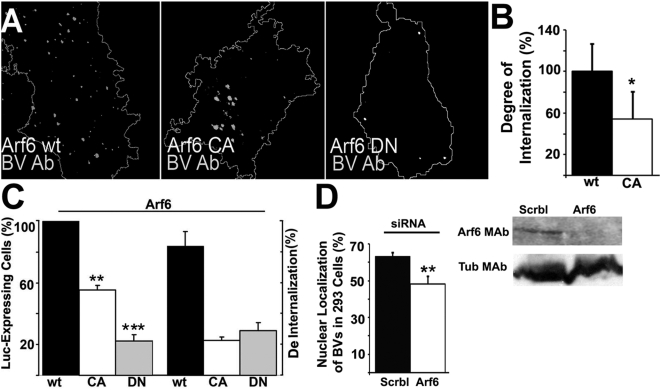
Arf6 is involved in baculovirus internalization and transgene expression.(A) 293 cells were transfected with Arf6 constructs (wt, CA, DN) for 48 h and then transduced with baculovirus (AcVP39 MOI 200). The virus uptake after 30 min was detected by baculovirus Ab and Alexa-555-conjugated secondary antibody. The cell boundaries were determined from DIC image by ImageJ. The ratio of internalized vs. surface baculovirus in WT or Arf6DN transfected cells (30 cells from three separate experiments) was calculated from confocal sections using a differential labeling of baculovirus before and after permeabilization and using an internalization algorithm in BioimageXD software (see Materials and Methods section). Mean values and standard errors are shown. (B) Baculovirus-mediated luciferase (Luc; Ac-luc, MOI 200) expression in 293 cells was measured after 24 h in the presence Arf6 plasmids (left columns). Dextran internalization (2 h p.t.) in Arf6 expressing cells was measured to verify the efficacy of the mutant plasmids (right columns). The results show the proportional amount of cells which showed significant amount of dextran entry (cells with at least 10 dextran-positive vesicles in the cytoplasm). Mean values and standard deviations are calculated from three separate experiments. (C) Arf6 was knocked down in 293 cells using siRNAs. After siRNA treatments nuclear localization of baculovirus was calculated after 6 h baculovirus transduction. Western blotting was used to monitor the knock down effect with Arf6 antibodies. Statistical significance was determined by using the unpaired Student t test with a two-tailed P value. *P<0.05, **P<0.01, ***P<0.001.